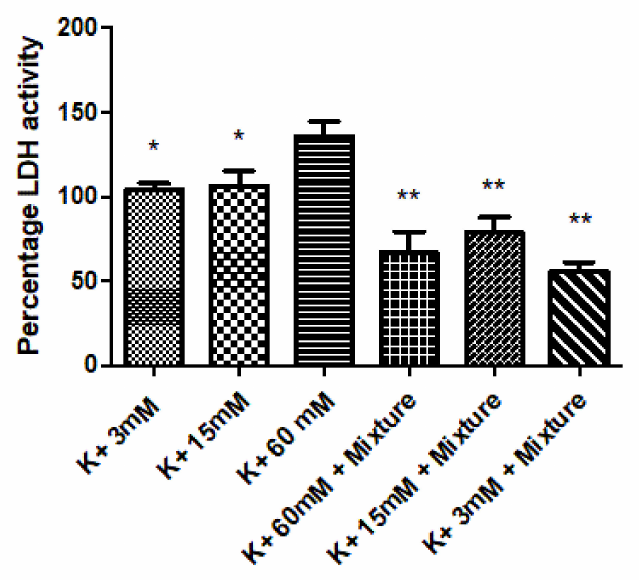
Figure 7. Inhibitory effect induced by the mixture (200 µ g/mL) on lactate dehydrogenase (LDH) level, in isolated mouse cortex specimens. ANOVA, p < 0.001; ** p < 0.01, * p < 0.05 vs. K + 60 mM.